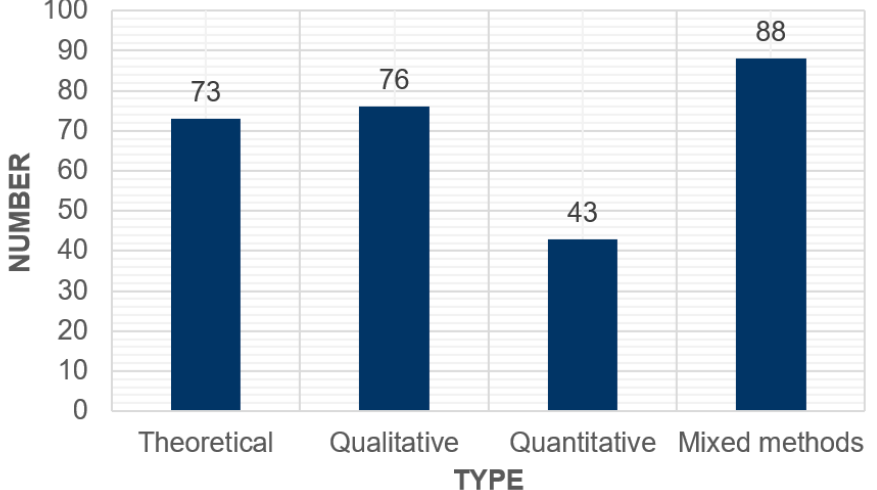
8 of 27 Table 6. Top five journals according to the number of published papers No.